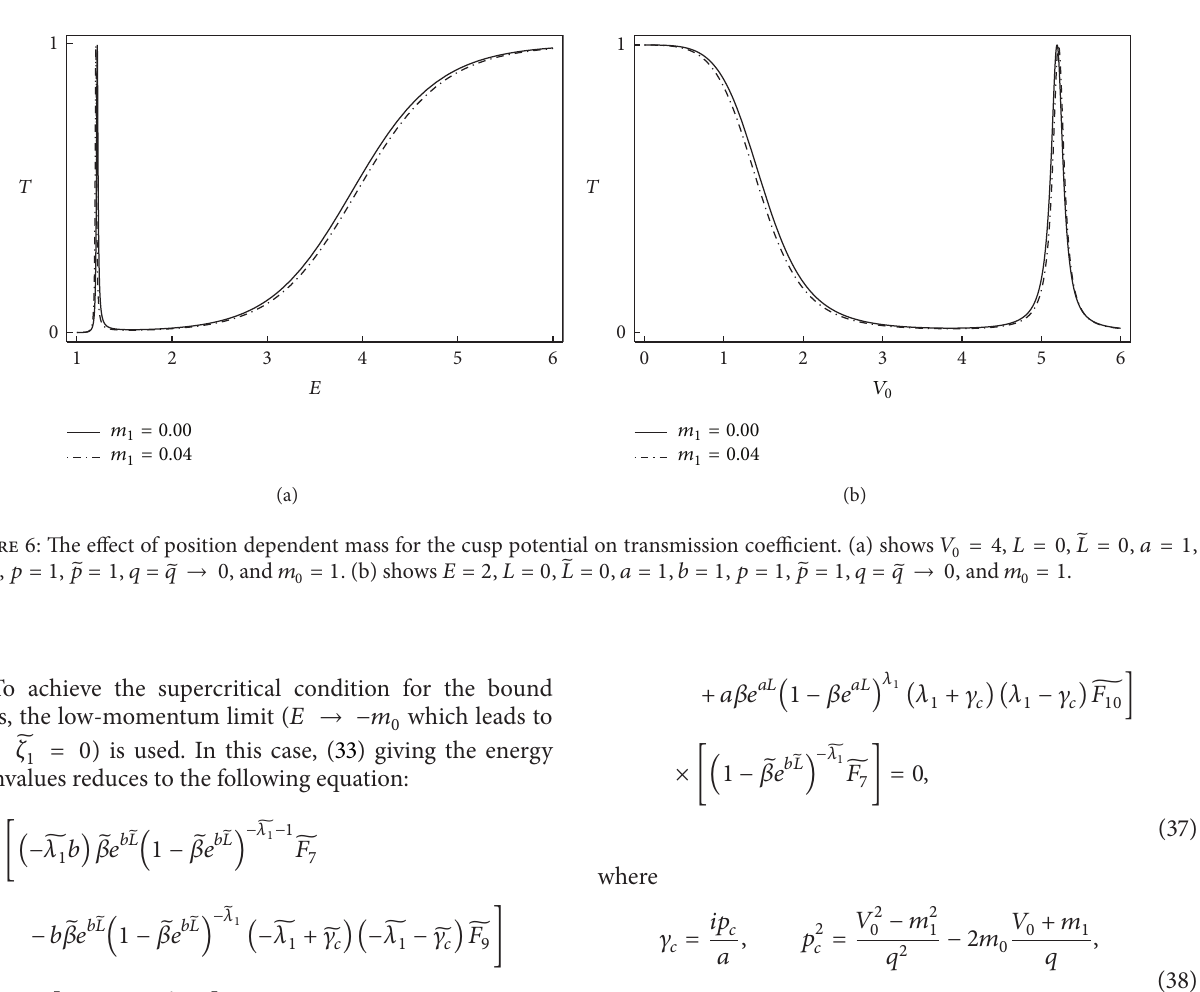
= 1 . (b) shows 𝐸 = 2 , 𝐿 = 0 , ̃ 𝐿 = 0 , 𝑎 = 1 , 𝑏 = 1 , 𝑝 = 1 , ̃ 𝑝 = 1 , 𝑞 = 0.5 , ̃𝑞 = 0.5 , and 𝑚 0